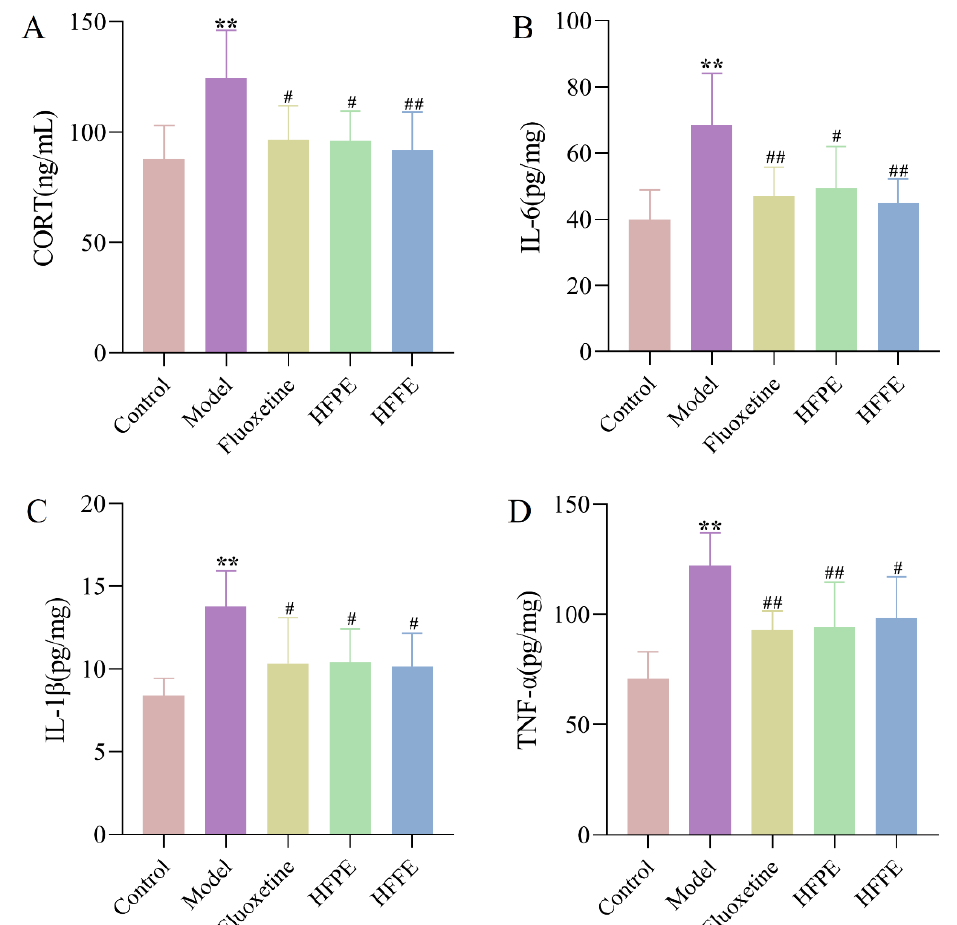
Figure 8. Effects of HFPE and HFFE on serum CORT level and the inflammatory level in hippocampus of CUMS rats. ELISA for detecting CORT ( A ), IL-6 ( B ), IL- 1β ( C ), and TNF- α ( D ) levels. Results were represented as mean ± SD ( n = 8). ** p < 0.01 compared with the control group, # p < 0.05 and ## p < 0.01 compared with the model group.